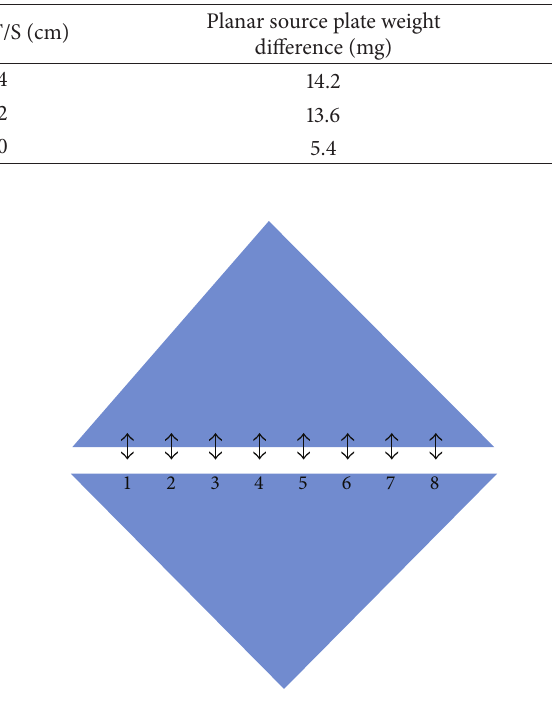
Table 3: Material utilization rate of the planar source.